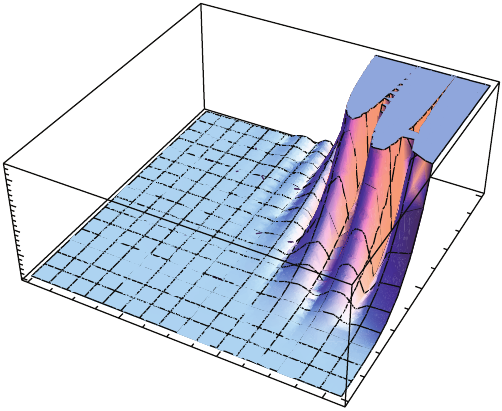
Figure 5: Numerical approximation of 𝑉(𝑥, 𝑡)